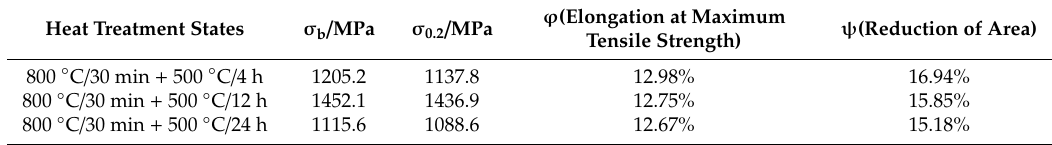
Table 2. Tensile properties of the alloy at room temperature.